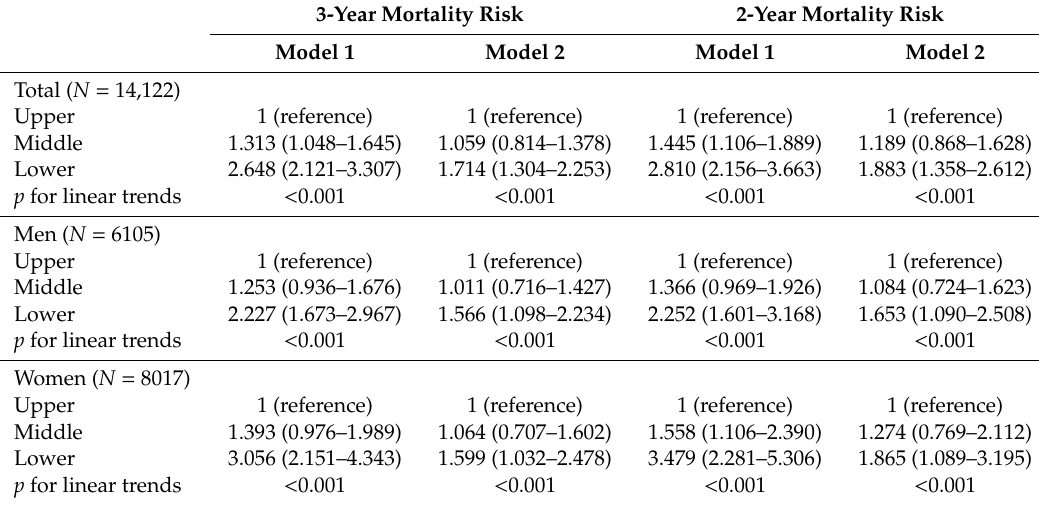
Table 2. Risks of all-cause mortality according to eCRF category (HR and 95%